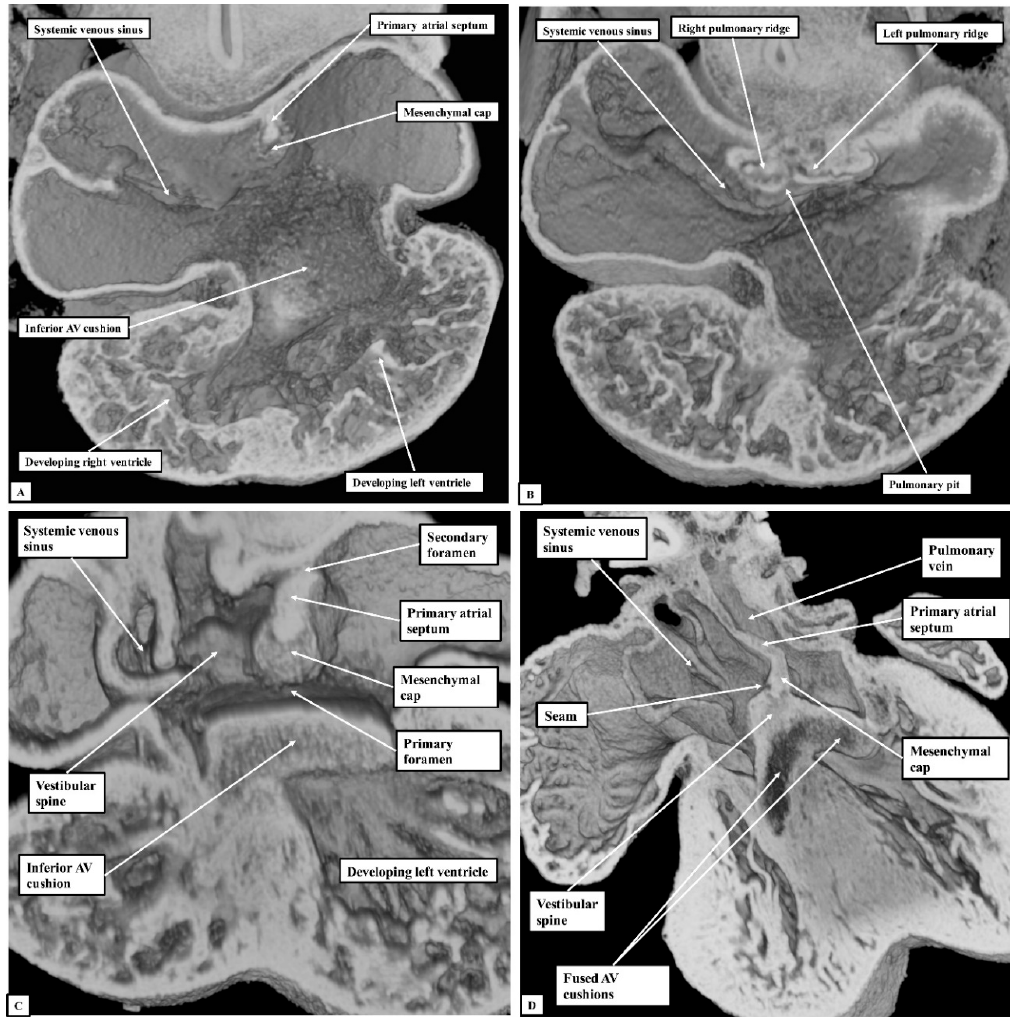
Figure 5. The images show ventral (Panel A ) and more dorsal (Panel B ) sections taken from the same episcopic dataset prepared from a developing mouse embryo sacrificed on the eleventh day of intrauterine development (E10.5). The lower panels show similar four-chamber sections at the stages of embryonic days 11.5 (Panel C ) and 13.5 (Panel D ) Abbreviation: AV—Atrioventricular. If development proceeds in a normal fashion, the margins of the oval fossa are intact by E15.5.